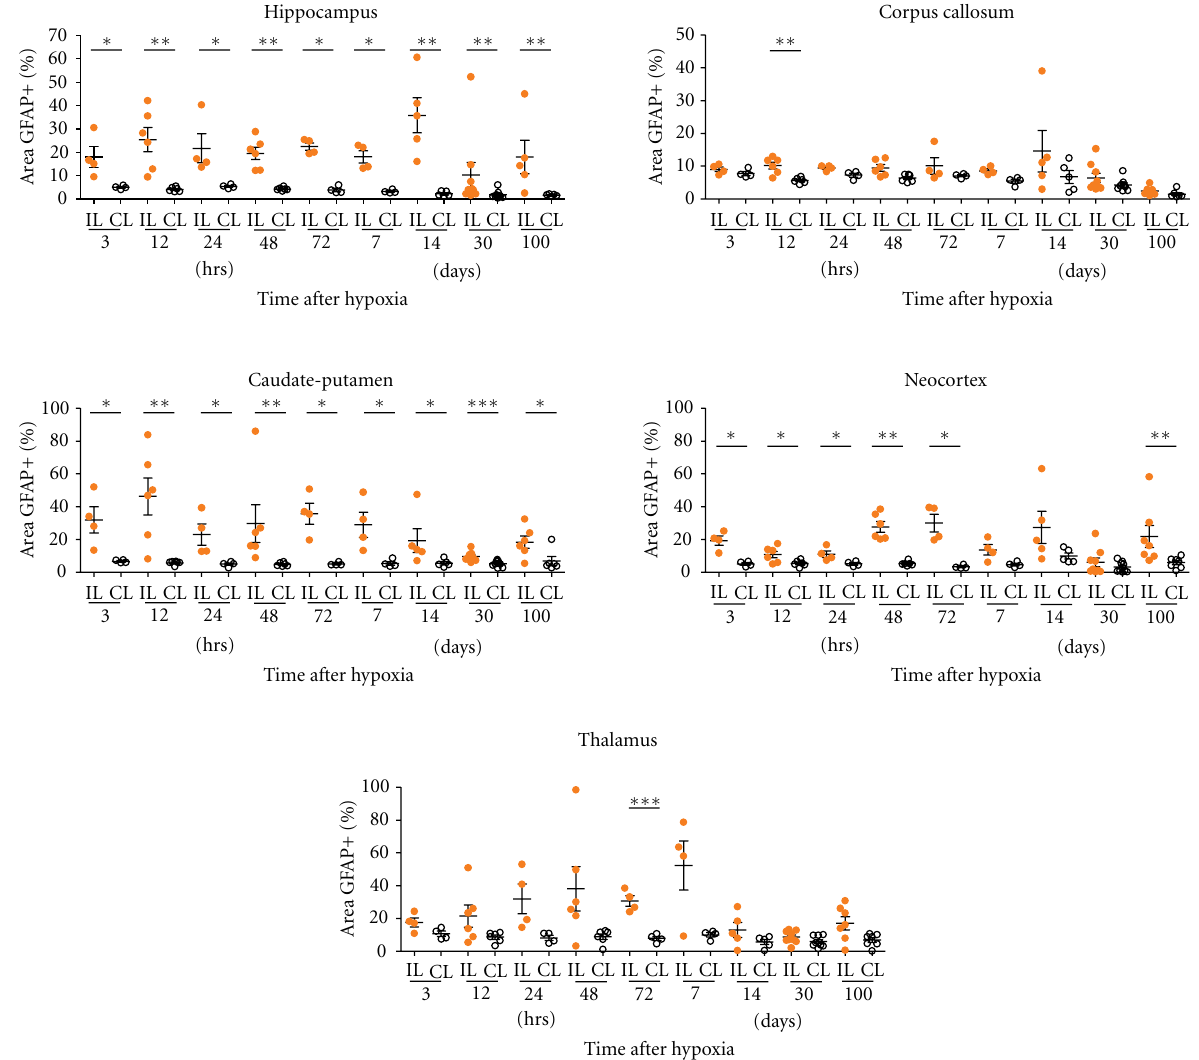
Figure 8: GFAP+ area on the hippocampus, corpus callosum, caudate-putamen, neocortex, and thalamus is evaluated from 3hrs to 100 days after hypoxia in the ipsilateral (IL) and contralateral (CL) hemispheres. Astrogliosis is shown as the percentage of the GFAP+ area (see Section 2 for details). The hippocampus and caudate-putamen are the most a ff ected regions and significant di ff erences between IL and CL hemispheres are found at all time points. The astroglial reactivity in corpus callosum is observed at 12hrs after hypoxia between IL and CL. Higher astrogliosis is observed in the ipsilateral neocortex at almost all times analyzed compared to CL side. A significant increase in astroglial activation after 72hrs is seen in the IL thalamus. Significant di ff erences between IL and CL hemisphere are shown using unpaired t tests, with Welch’s correction if suitable ( ∗ P < 0 . 05, ∗∗ P < 0 . 01, ∗∗∗ P < 0 . 001). Individual data and mean ± S.E.M, are represented to show the dispersion in each